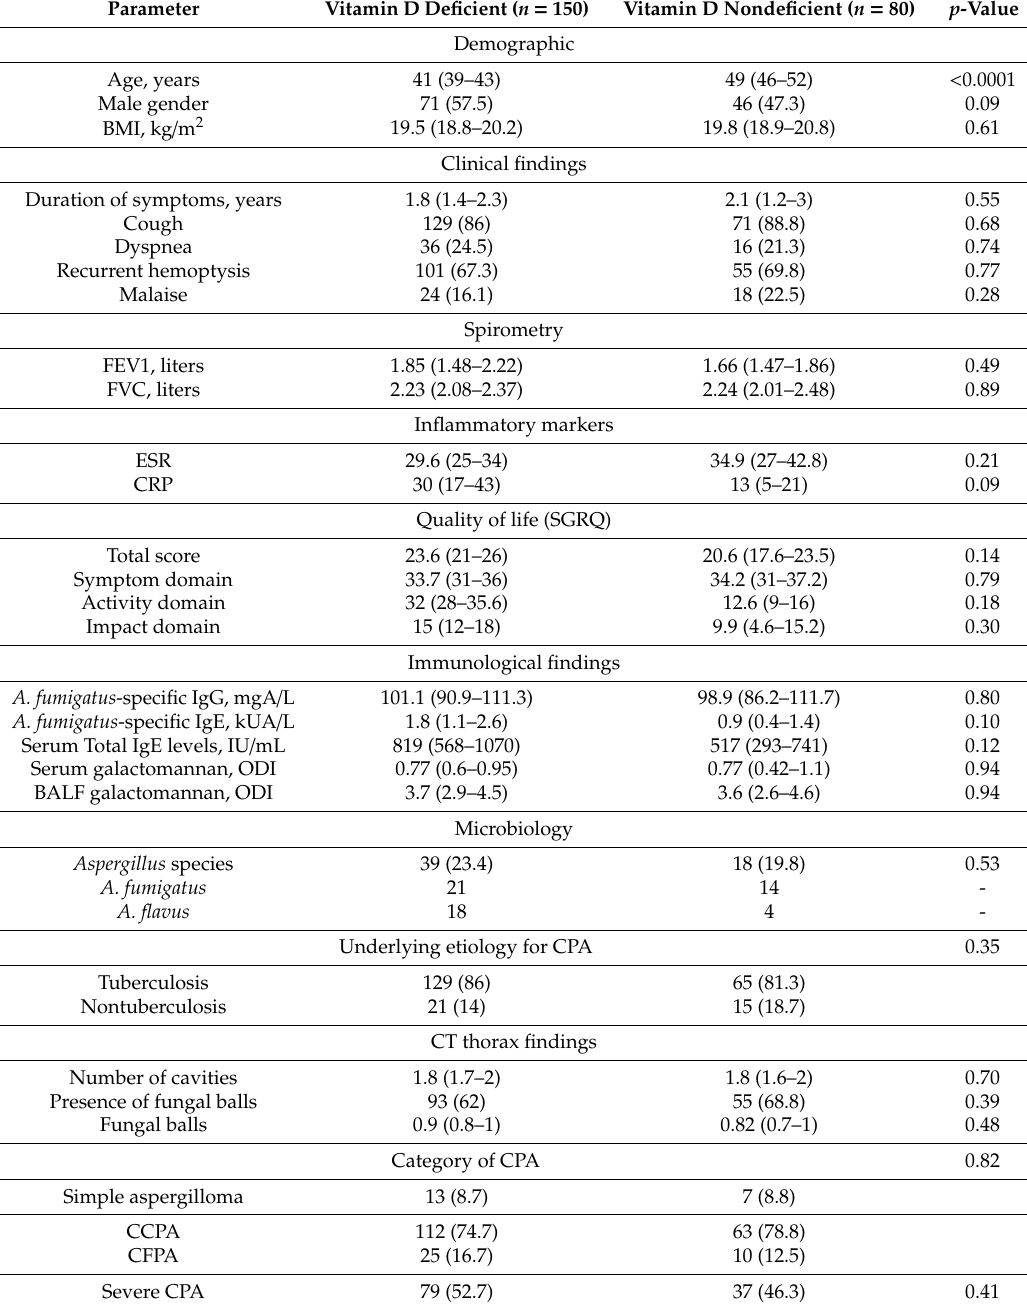
Table 3. Demographics and clinical profile of subjects with CPA with or without vitamin D deficiency ( < 20 ng /